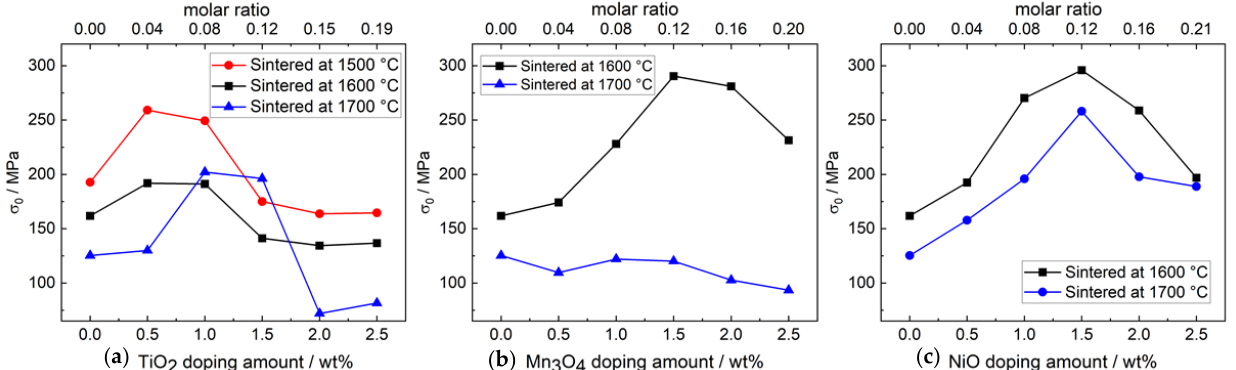
Figure 15. ( a ) Characteristic fracture strength σ 0 of TiO 2 -doped Na- β″ -alumina. The results of TiO 2 -doped samples and sintering temperatures of 1500 °C and 1600 °C are reprinted with permission from Dirksen et al. [13]. ( b ) Characteristic fracture strength σ 0 of Mn 3 O 4 -doped Na- β″ -alumina. ( c ) Characteristic fracture strength σ 0 of NiO-doped Na- β″ -alumina.